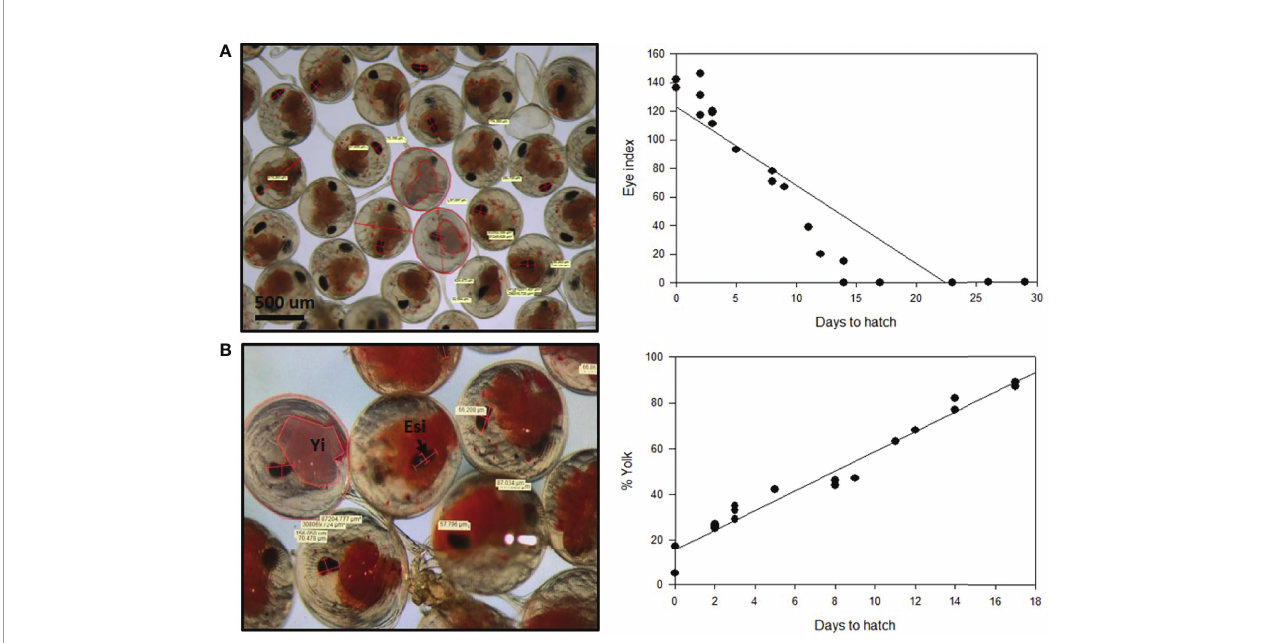
FIGURE 6 | Hatch prediction models for developing Panulirus ornatus embryos based on eye index (A) and yolk percentage (B) . Embryos were kept at 26°C at the Institute for Marine and Antarctic Studies (IMAS). Eye index = length of eye + width of eye (widest section)/number of measurements taken. Photos and measurements taken by Larnie